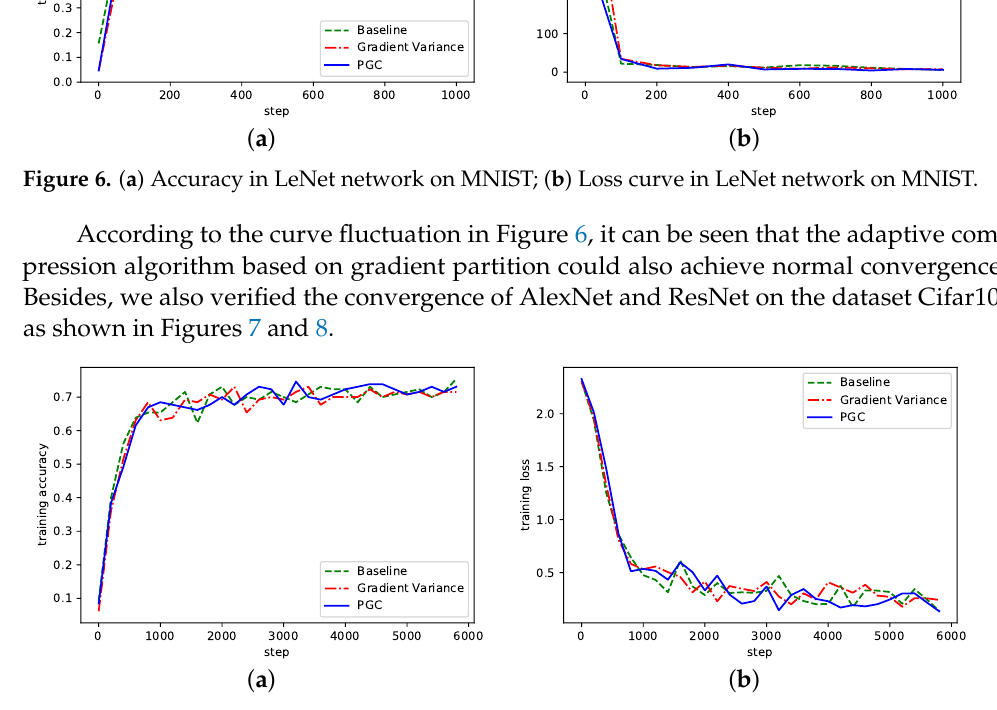
Figure 7. ( a ) Accuracy in AlexNet network on Cifar10; ( b ) Loss curve in AlexNet network on Cifar10.